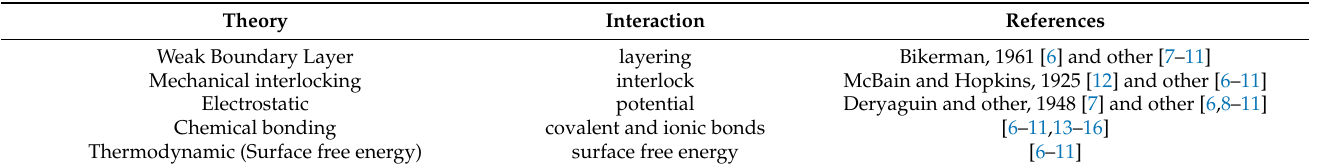
Table 1. Theories explaining the adhesion mechanism in the bitumen/aggregate system.